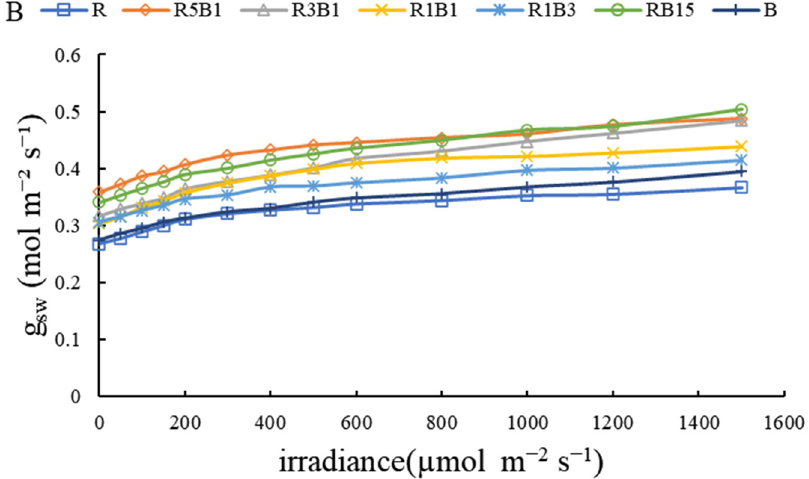
Figure 6. Light response curves under seven different red and blue light ratio treatments ( A ). Stomatal conductance response curves under seven different red and blue light treatment ( B ). R: monochromatic red light; R1B5: red to blue ratio = 1:5; R1B3: red to blue ratio = 1:3; R1B1: red to blue ratio = 1:1; R1B3: red to blue ratio = 1:3; R1B5: red to blue ratio = 1:5; B: monochromatic blue light.